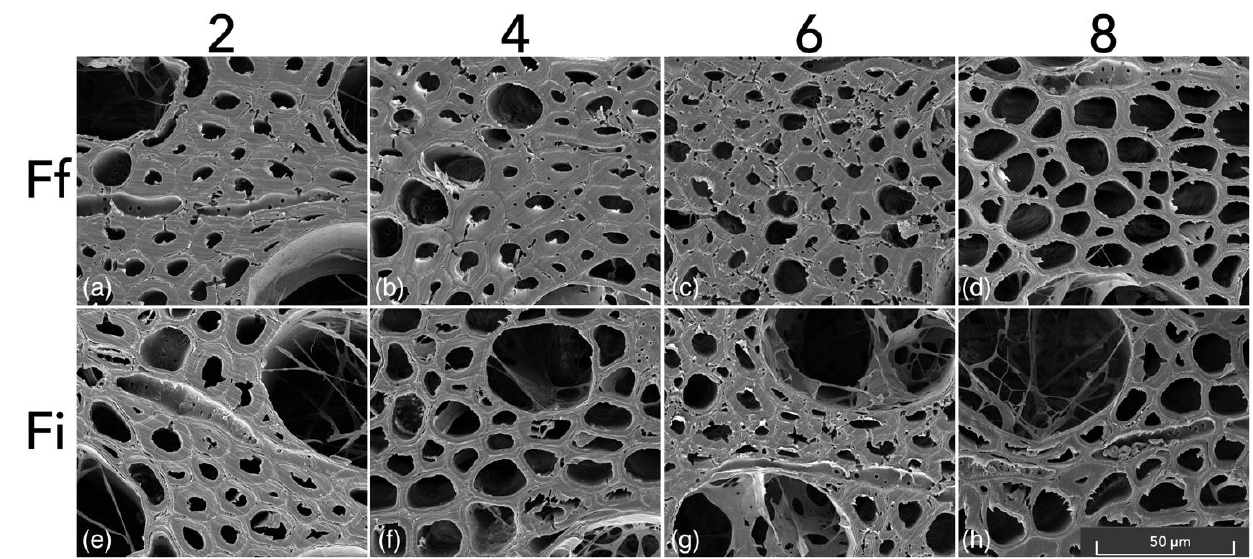
Figure 3. SEM scans of mass-loss-degraded samples exposed to F. fomentarius ( a – d ) and F. inzengae ( e – h ). Numbers refer to the inoculation period in weeks. Larger high-quality images are available in Supplementary Materials (Figures S1 – S8).